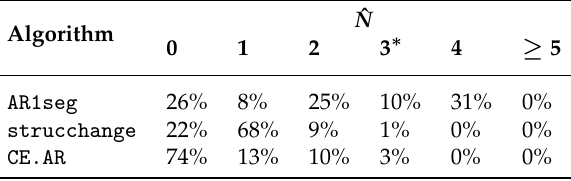
Table 5. Estimated number of multiple change points.